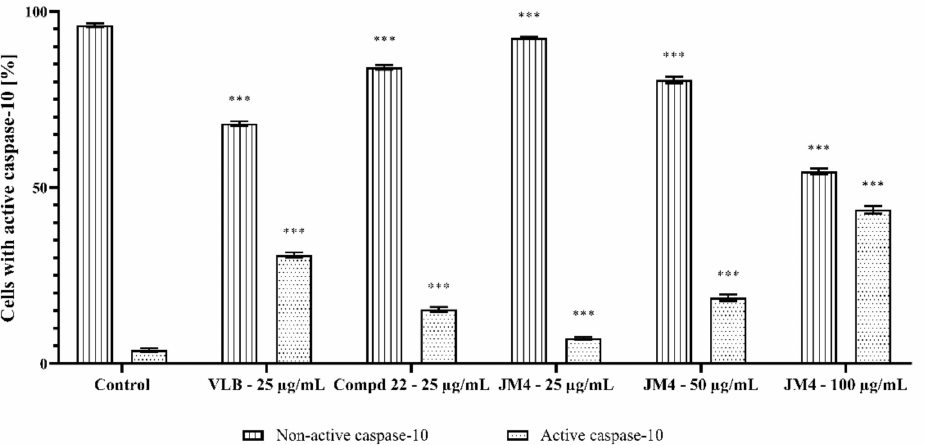
Figure 18. Percentage of C32 melanoma cells with nonactive and active caspase-10 after 24 h incubation with JM4 (25, 50, 100 µ g/mL), 22 (25 µ g/mL) and vinblastine sulfate (VLB) (25 µ g/mL). Mean percentage values from three independent experiments ( n = 3) done in duplicate are presented. *** p < 0.001 versus control